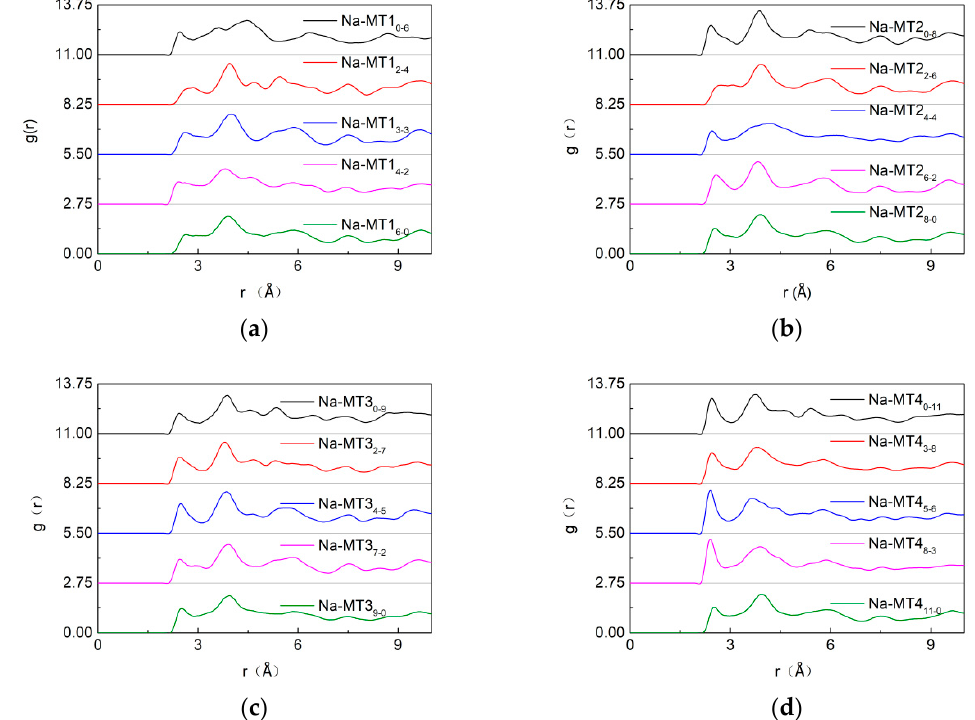
Figure 10. The RDF of O t -Na in Na-MT with different layer charge density.